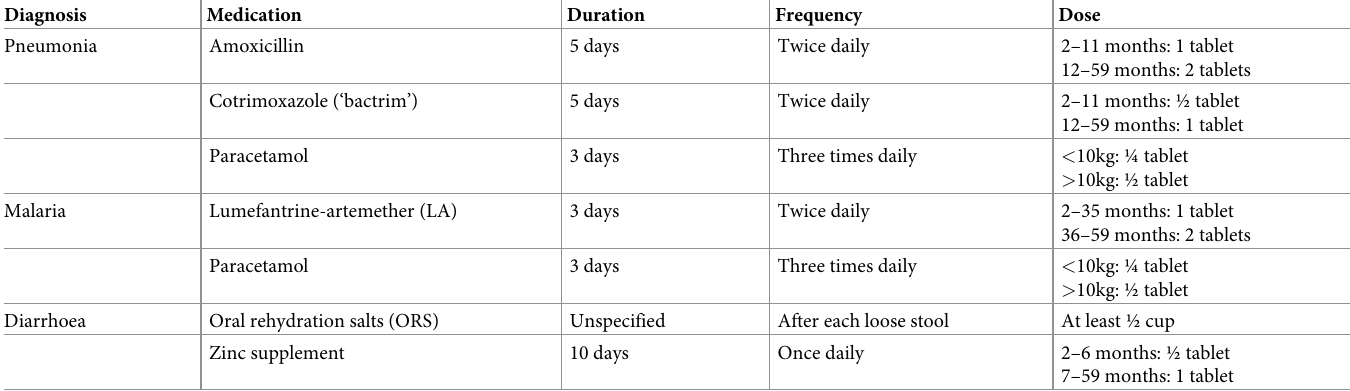
Table 1. Integrated community case management treatment guidelines for Malawi for children aged 2–59 months old